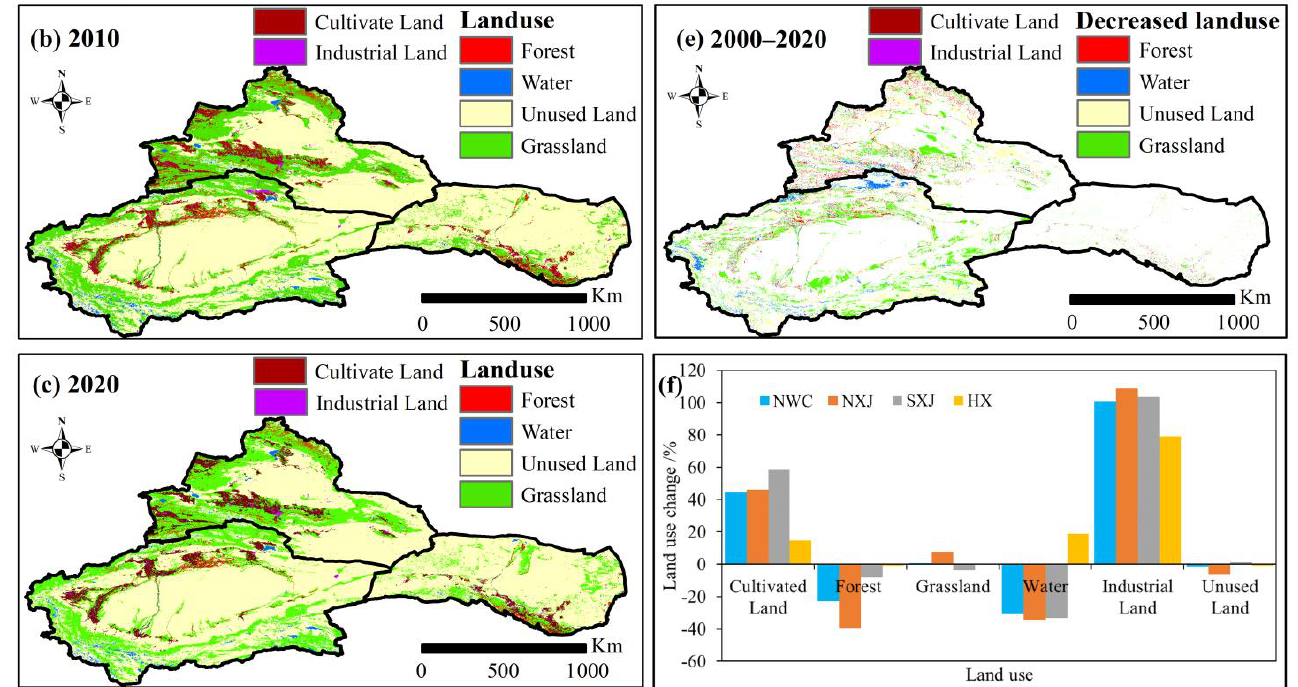
Figure 9. Temporal and spatial variations of land use during 2000 − 2020. Temporal variations of land use during ( a ) 2000, ( b ) 2010, and ( c ) 2020; ( d ) spatial variations of increased land use during 2000 − 2020; ( e ) spatial variations of decreased land use during 2000 − 2020; ( f ) temporal variations of land use during 2000 − 2020.